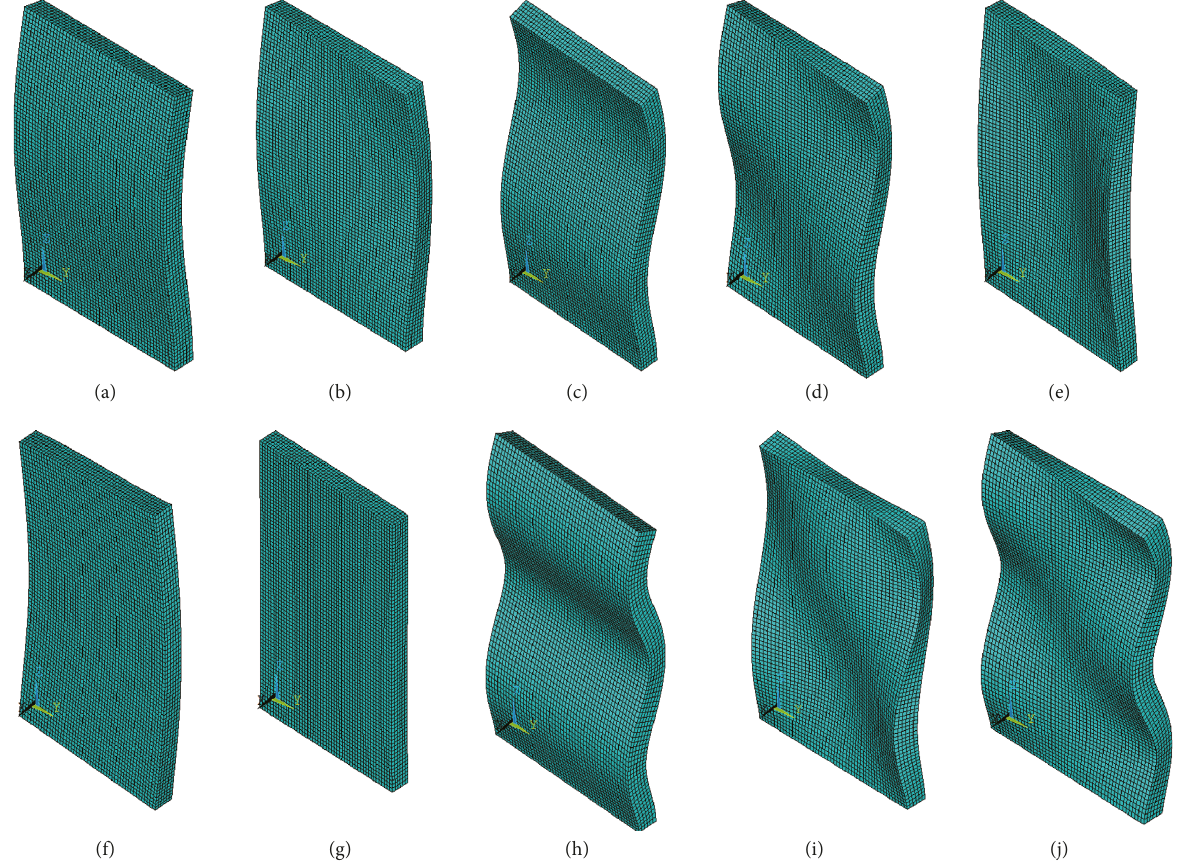
� 21.94Hz). (b) Mode 2 ( f � 37.57Hz). (c) Mode 3 ( f � 68.70Hz). (d) 1 2 3